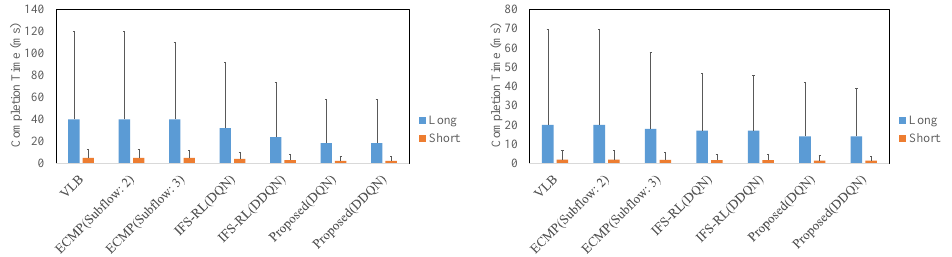
Figure 11. The average flow completion time in different data center architecture (( Left ): the case for complex architecture, ( Right ): the case for non-complex architecture).